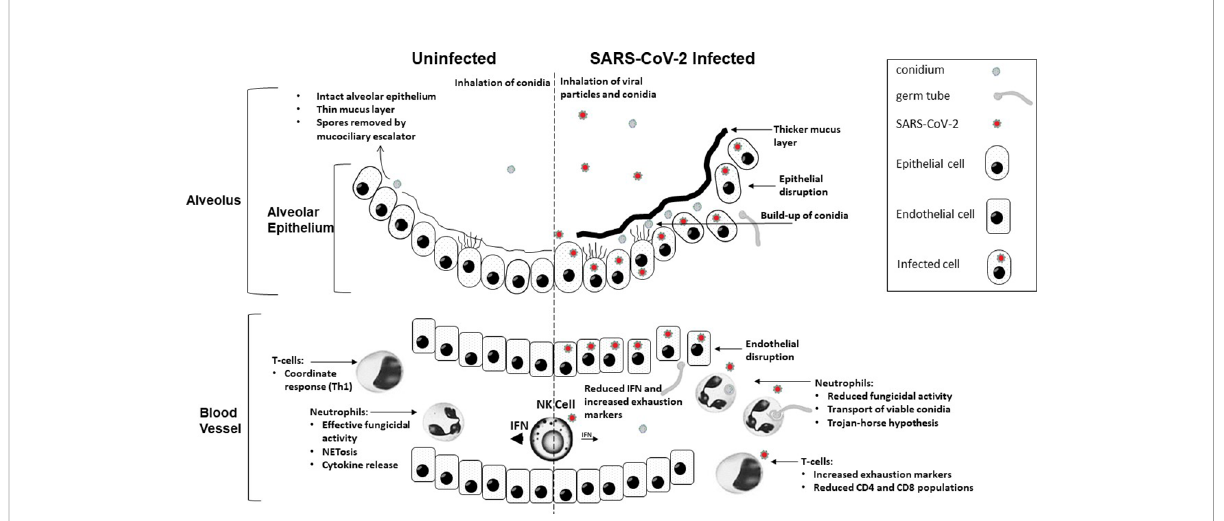
FIGURE 1 A graphical summary demonstrating how COVID-19 infection contributes to increased susceptibility to invasive fungal